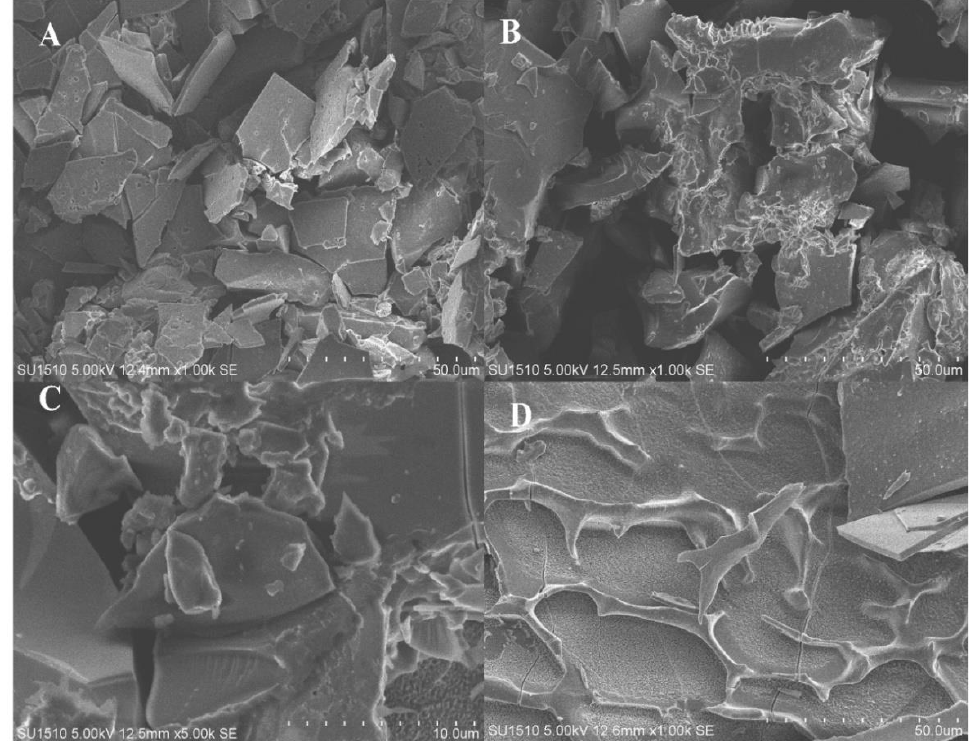
Figure 4. Scanning electron microscopy (SEM) of fish protein hydrolysates during different hydrolysis times and with fresh sample. ( A ) DH 13.36%, ( B ) DH 17.09%, ( C ) DH 20.15%, and ( D ) fresh fish sample.